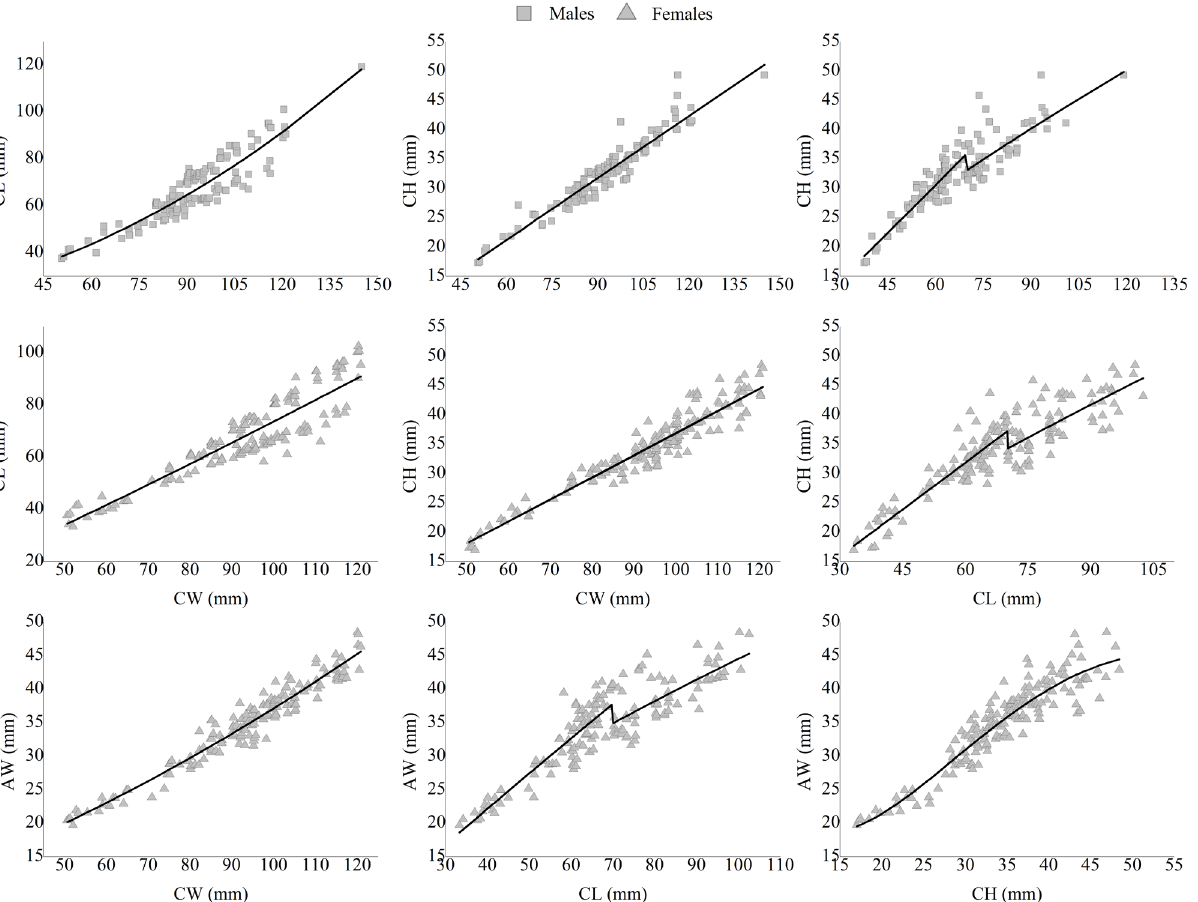
Figure 4. Raw data and the best models fitted to the morphometric relationships of Menippe frontalis in the Gulf of Guayaquil, Ecuador. CW, carapace width; CL, Carapace length; CH, carapace height; AW, abdomen